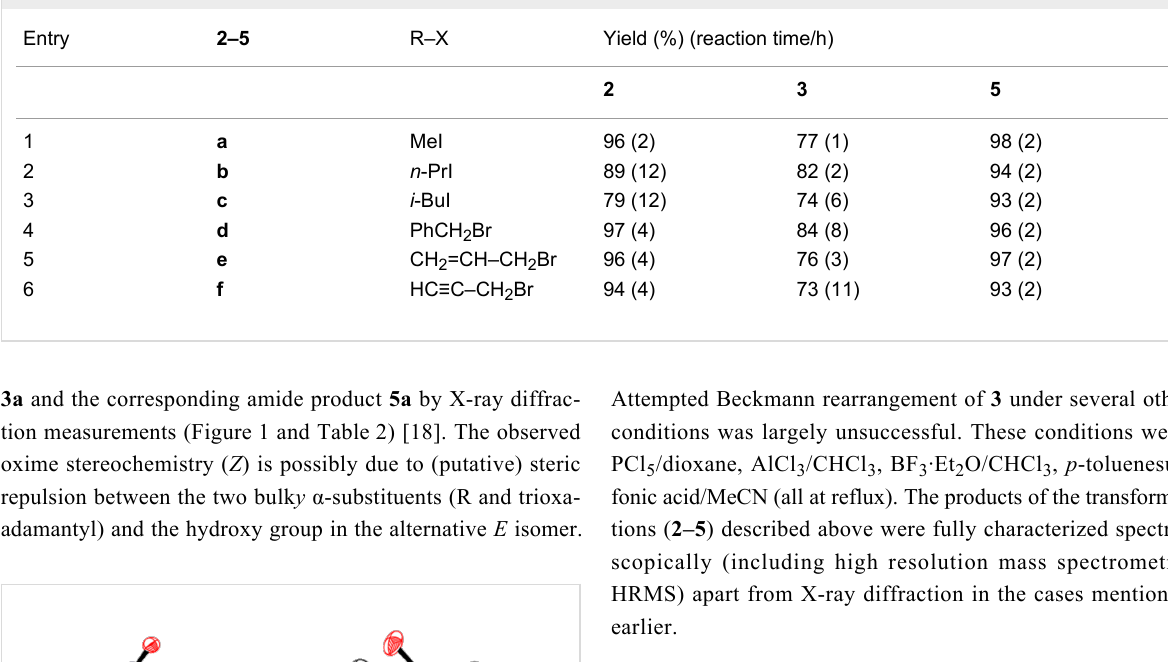
Table 1: Percentage yields of intermediate and final products of the transformation of 1 to 5 (Scheme 1) along with reaction times for their formation. Entry